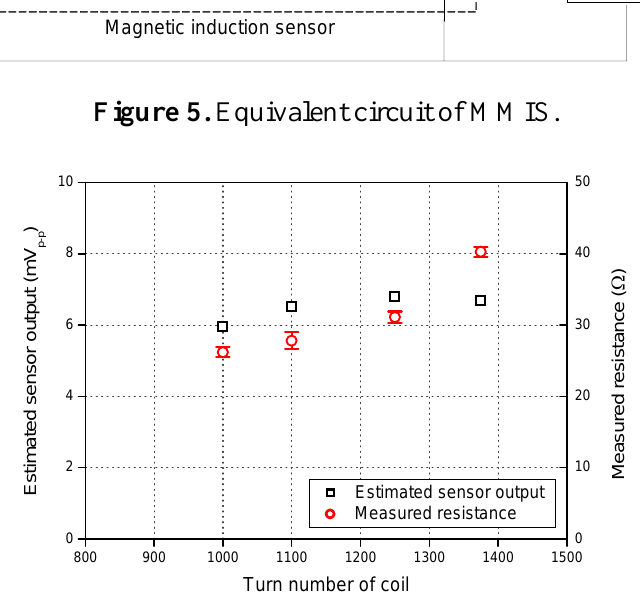
Figure 6 . Estimated induction voltage of MMIS and measured resistance as function of turn number of coil at magnetic flux density of 0.05 mT, rotational velocity of 30,000 rpm and angle between magnetic field and ammunition rotation axis of